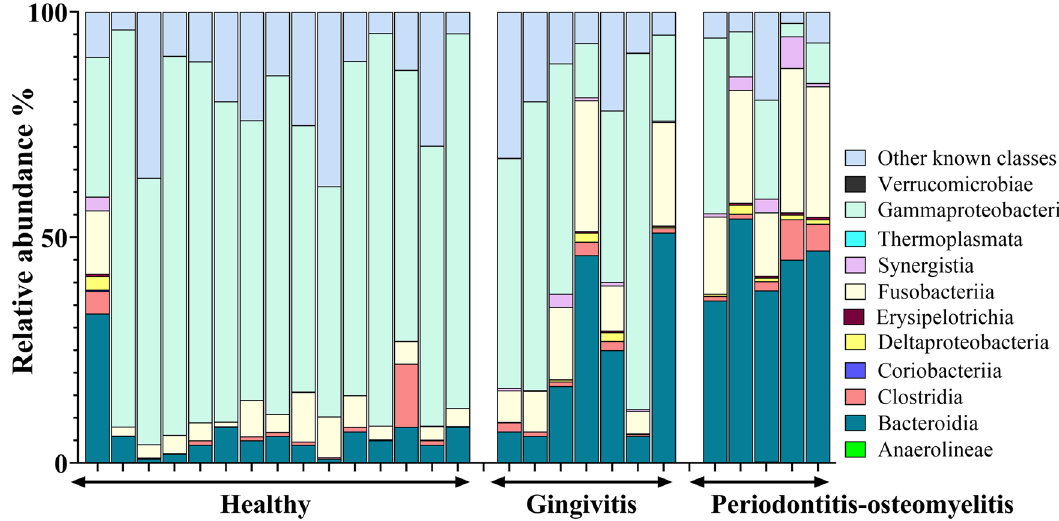
Figure 2. Microbiota of oral healthy macropod samples (n = 15) compared to gingivitis (n = 7) and periodontitis-osteomyelitis samples (n = 5) at the class level.